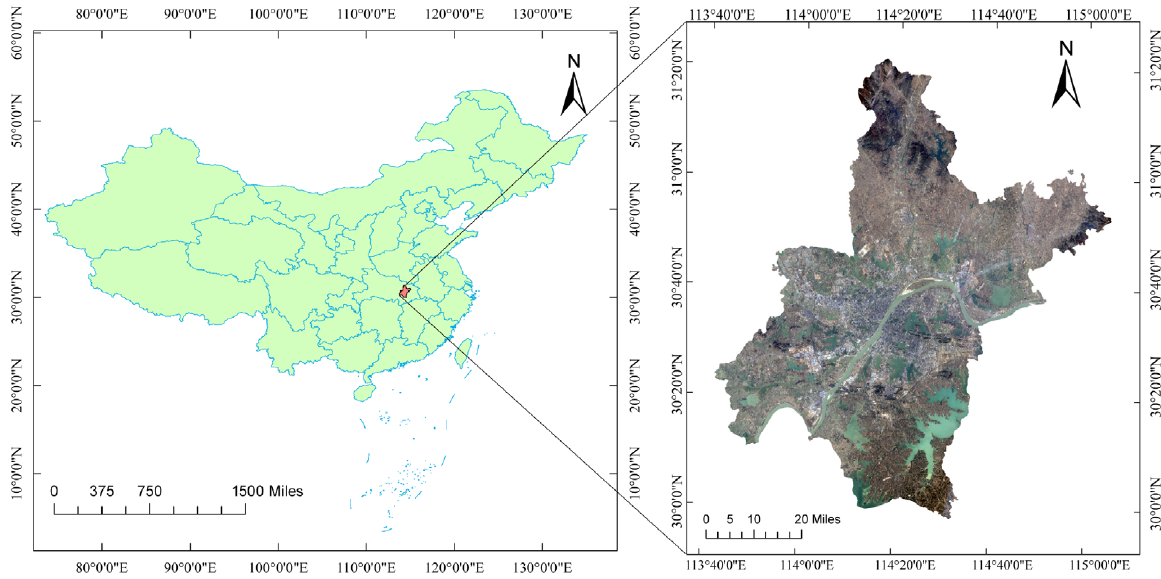
Figure 1. Location of the study area in China; standard false-color satellite image of Wuhan, composed of bands 4, 3, and 2 from the Landsat 8 satellite.